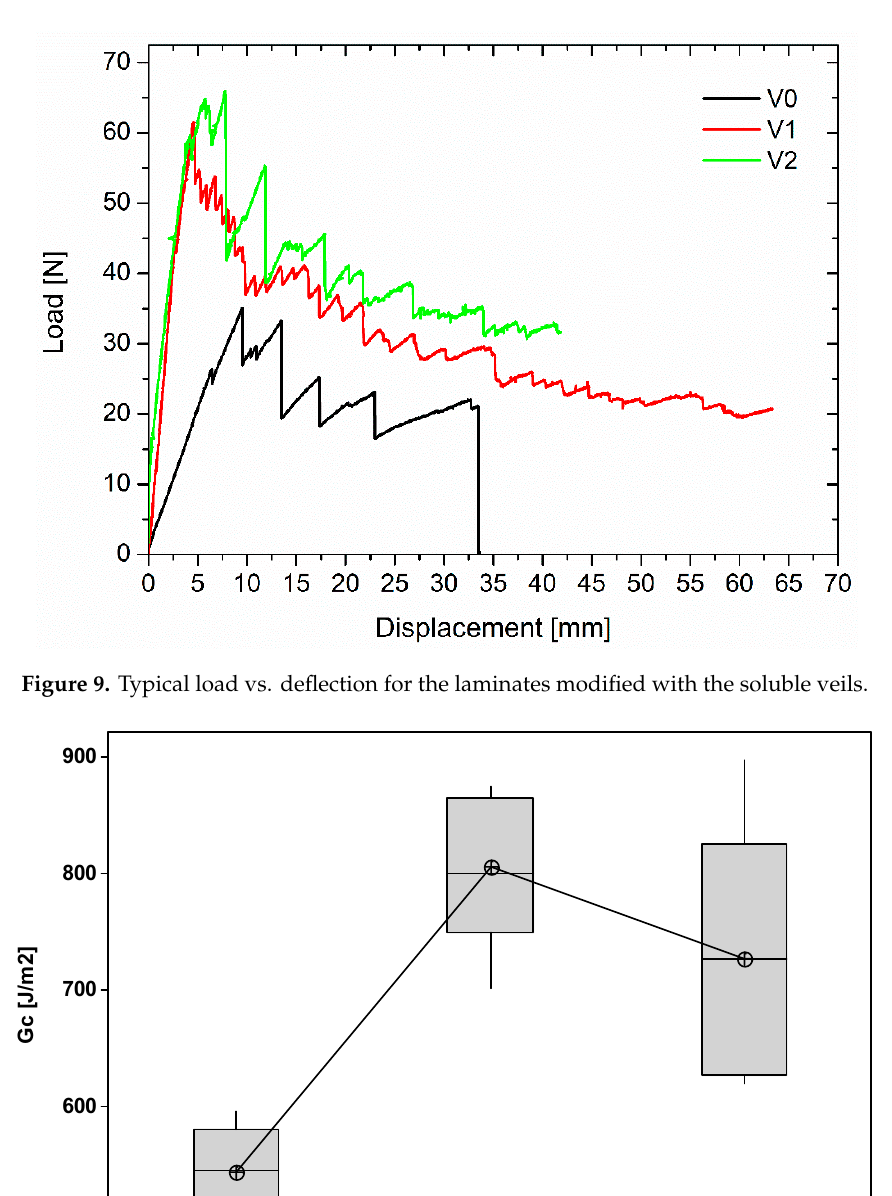
Figure 8. G IC values for the laminates modified with insoluble veils.